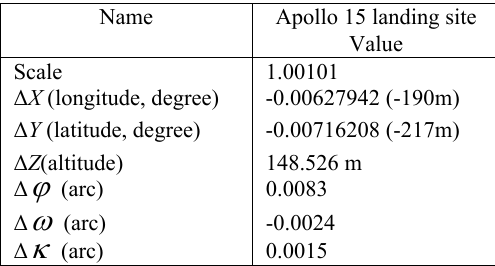
Table 3. Transformation parameters between Chang’E-1 and SELENE laser altimeter data at the Apollo 15 Landing Site